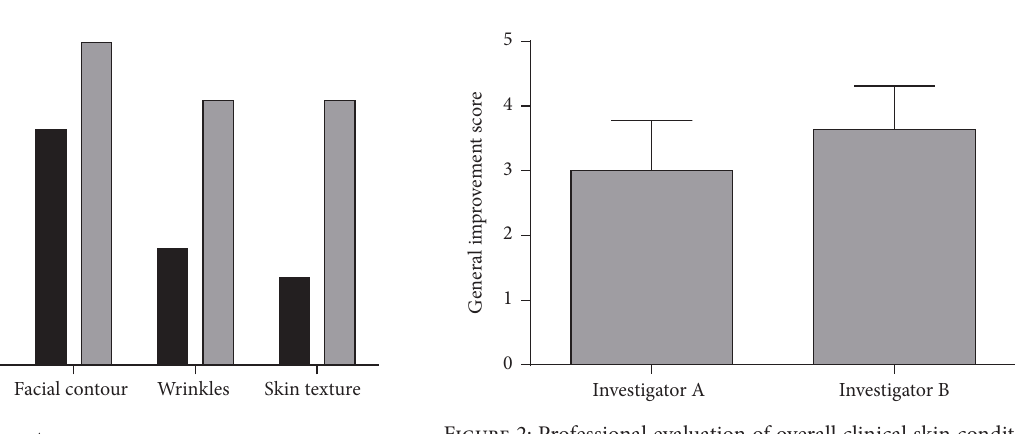
Figure 2: Professional evaluation of overall clinical skin condition improvement. Data are expressed as mean ± standard deviation of a 0 to 4 Global Aesthetic Improvement Scale